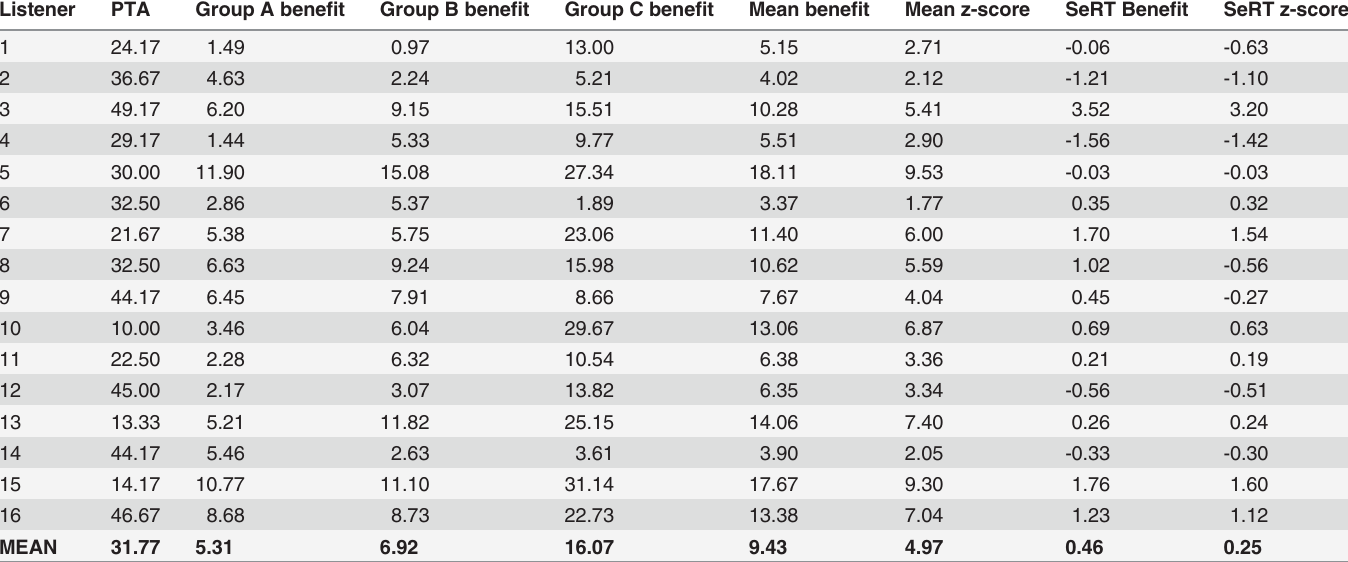
Table 1. Training results from individual listeners. Listener